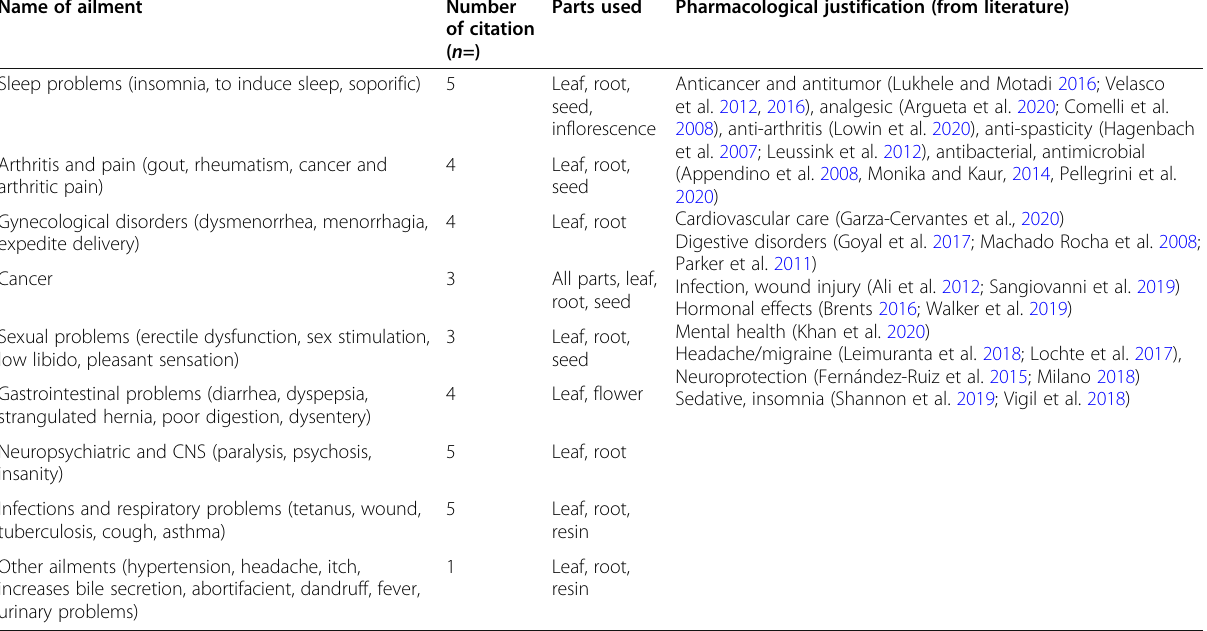
Table 1 Number of cited ailments treated by folk medicine practitioners of Bangladesh using different parts of Cannabis sativa Name of